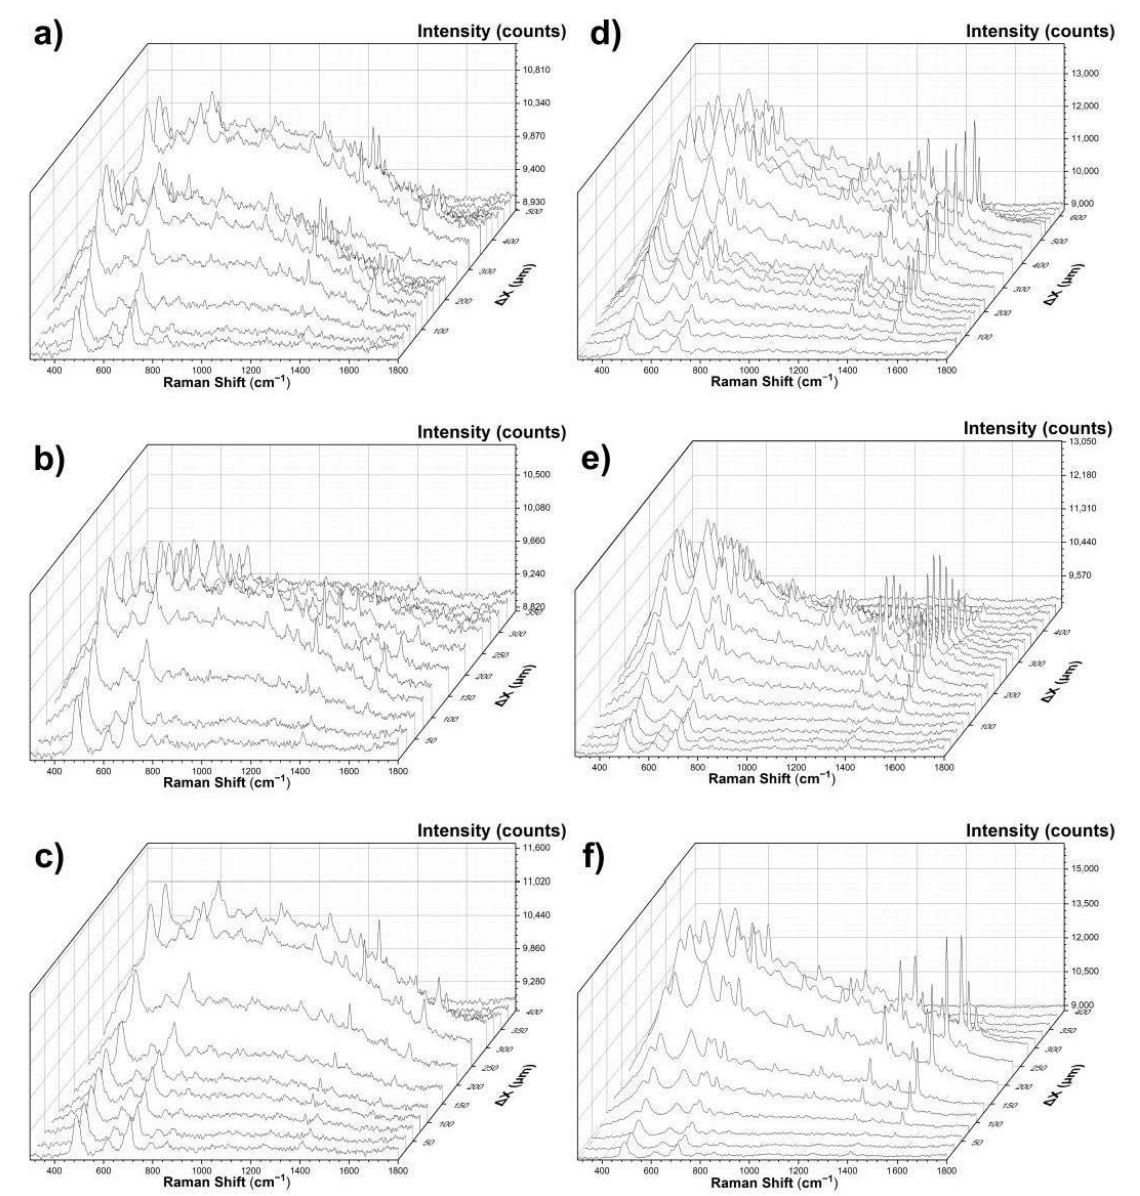
Figure 6. Raman spectra ( a – c ) show surface scanning results for Ink 2, respectively, in Phantoms A, B, and C, while the spectra ( d – f ) present scanning results for Ink 4 in the same phantoms.